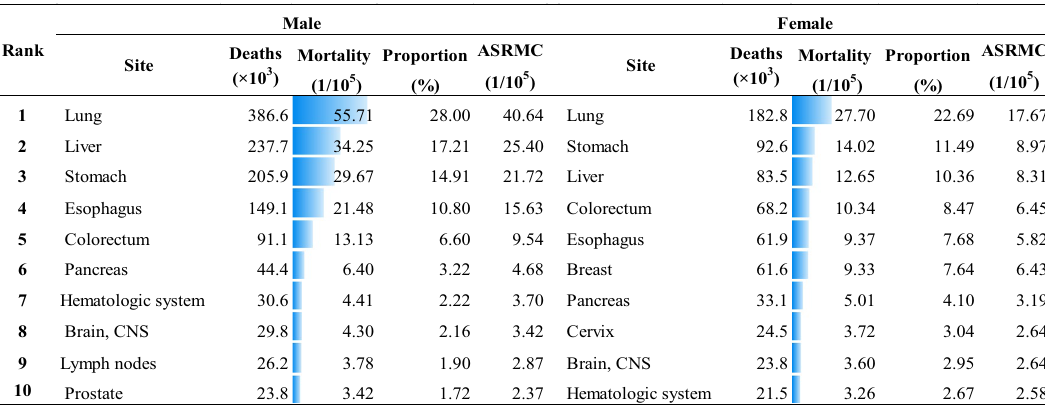
Table 4 Top ten cancer mortalities in China in 2012 (This table is modified from a previous publication with permission, see Ref.